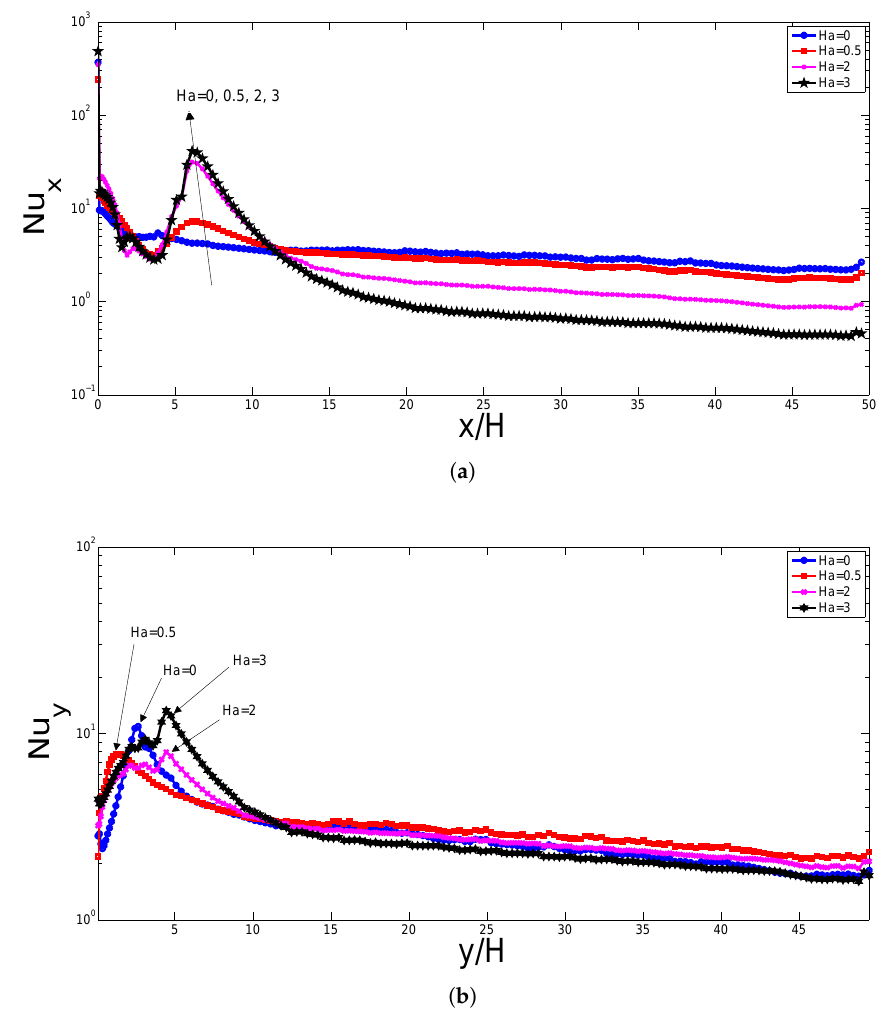
Figure 6. Effects of Hartmann number on the local Nusselt number variations for the upper hot walls of the vertical and horizontal exit channels (Re = 300, φ = 0.02): ( a ) W2, local Nusselt number variation; and ( b ) W4, local Nusselt number